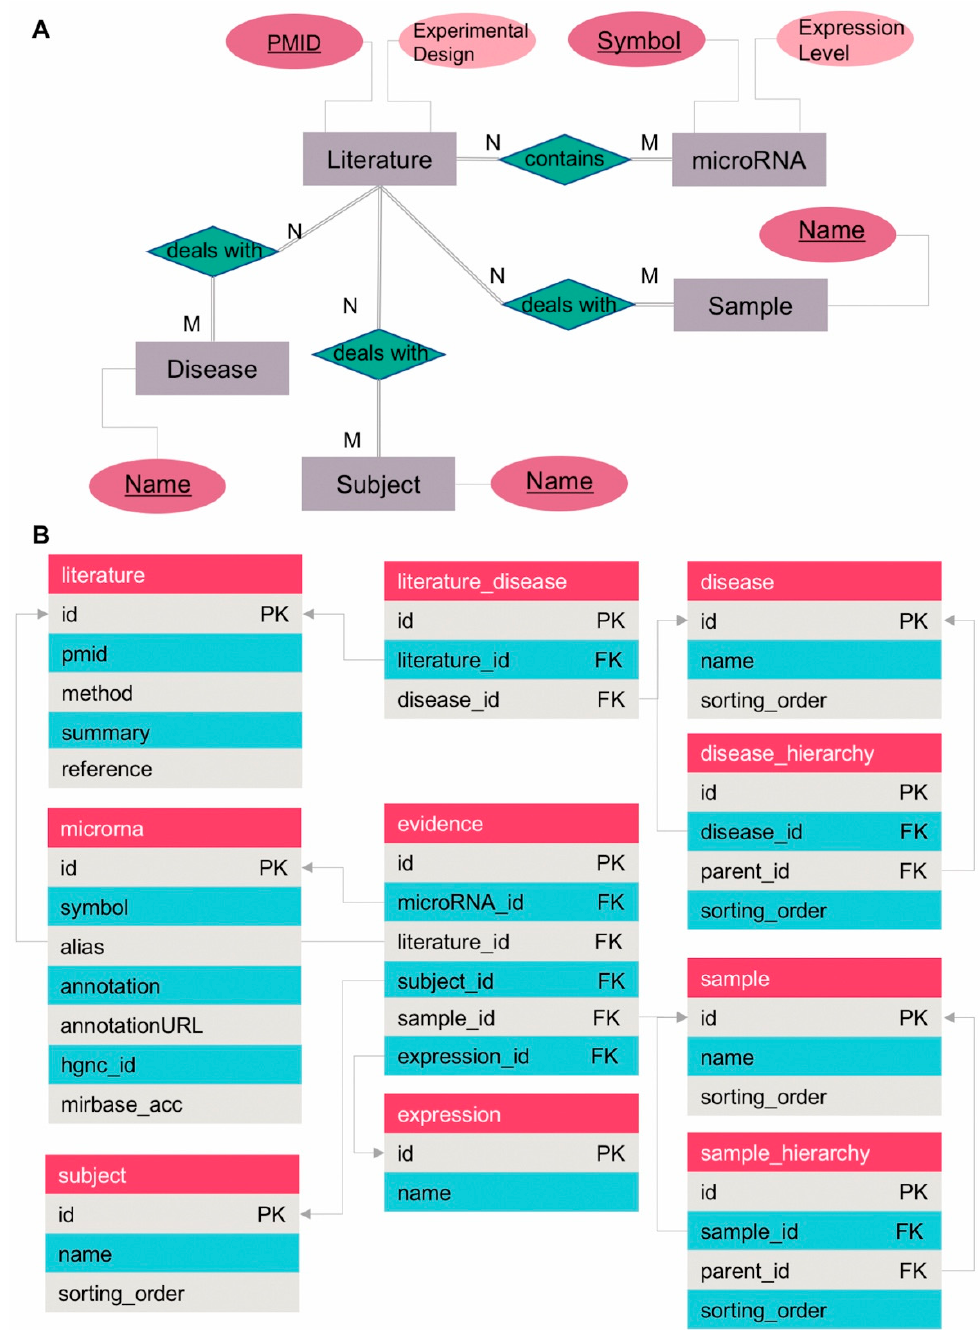
Figure 2. Our database model diagrams. ( A ) An entity relationship (ER) model diagram of miR2Diabetes, using the notation of Chen [23]. Gray squares represent entities and dark green diamond shapes are relationships. An ellipse shape is an attribute, divided such that a dark pink ellipse shape is a key attribute, and a pink ellipse shape is an important attribute to handle. ( B ) A table-like model diagram of miR2Diabetes. A dark pink square represents a table name. Gray and cyan squares are fields of a table. PK means a primary key of its table and FK means a foreign key to another table (indicated by arrows). Detailed definitions of our table-like model are downloadable from the miR2Diabetes website [22].